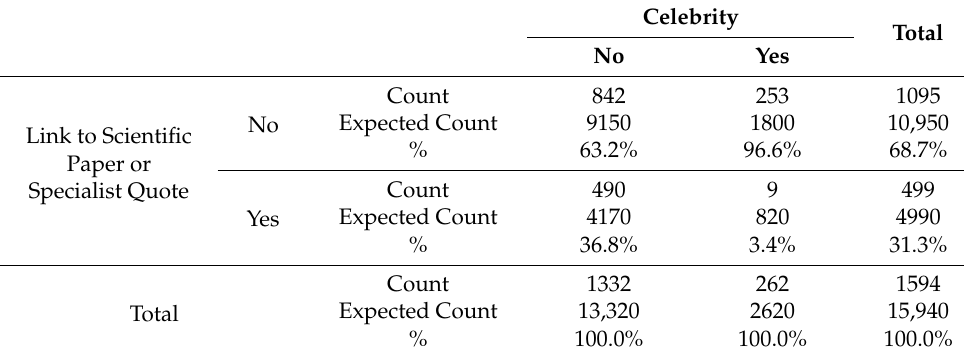
Table 4. Frequency that links to scientific papers and quotes from health specialists appearing in news stories.